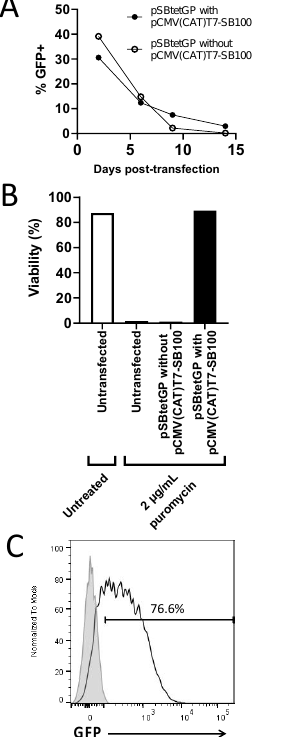
Figure 1. Assessing integration of the SB vector: ( A ) HEK293T cells were lipofectamine 3000 trans- fected with pSBtetGP:Luciferase plasmid with or without the pCMV(CAT)T7-SB100 transposase containing plasmid. HEK293T cells were analysed on days 2, 6, 9 and 14 for GFP expression by flow cytometry. ( B , C ) Untransfected or transfected HEK293T cells at day 14 were then treated with or without 2 µg/mL puromycin as stated for seven days. ( B ) Cell viability was then analysed by trypan blue staining, and ( C ) HEK293T cells transfected with pSBtetGP:Luciferase and the pCMV(CAT)T7- SB100 plasmids (black line) or untransfected control (grey shaded peak) were analysed for GFP ex- pression by flow cytometry. 3.2. Optimisation of rtTA-M2 Variants in a Stably Integrated Sleeping Beauty Transposon Containing an Inducible Tet-On Cassette We aimed to improve the current rtTA activity through the comparison of multiple combinations (or alone) of the G72V mutation, SE mutations, and/or removal of additional